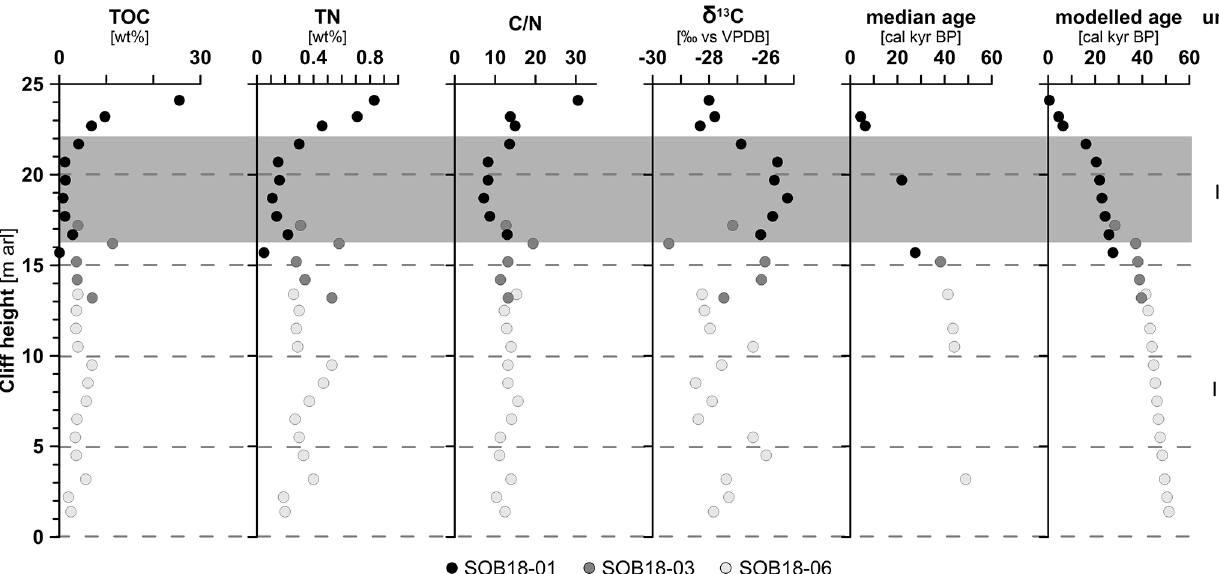
Figure 2. Biogeochemical parameters of the Sobo-Sise Yedoma cliff: total organic carbon (TOC) content, total nitrogen (TN) content, carbon-to-nitrogen (C / N) ratio, bulk stable carbon isotope ratios ( δ 13 C), radiocarbon ages and modelled age in calibrated kiloyears before present (calkyrBP). Data points are displayed over cliff height from the cliff top at 25m above river level (a.r.l.) to cliff bottom at 0ma.r.l. The three sections of SOB18 are plotted separately for each parameter (black, dark grey and light grey circles). Units I, II (grey rectangle) and III correspond to Marine Isotope Stage (MIS) 1 to 3, respectively. The radiocarbon ages were published in Wetterich et al.